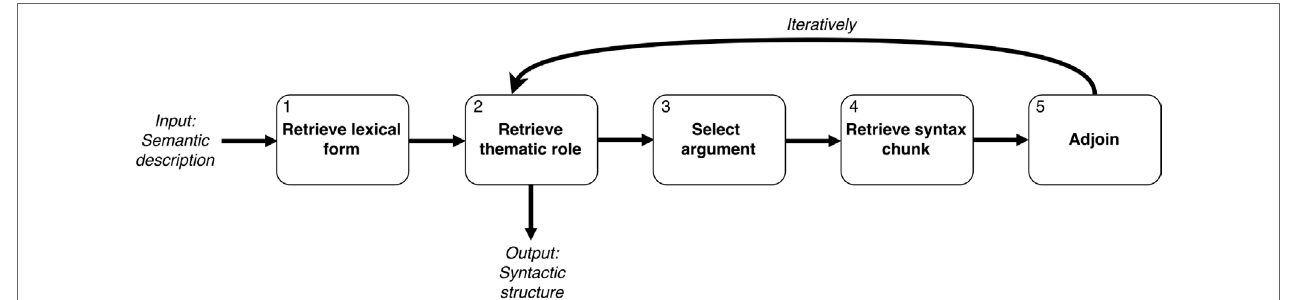
FigURe 5 | Overview of the processing steps of RK&M’s syntactic priming model, which produces the syntactic structure of a sentence such as Example (3) [based on Reitter et al. (2011)]. First, retrievals of the lexical form of the head and a thematic role are done. Then, the model selects an argument for the thematic role